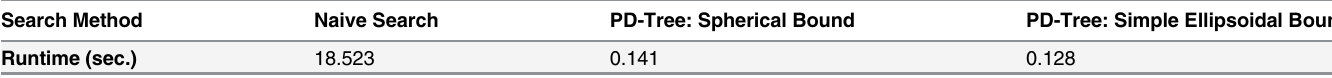
Table 14. IMLP runtime comparison using different PD-tree bounding methods for computing the most-likely matches. Search